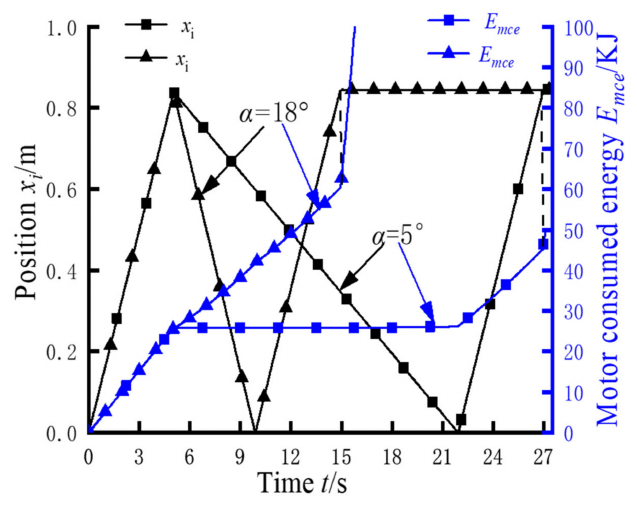
Figure 15. Load position and motor energy consumption under different swashplate inclinations in descending